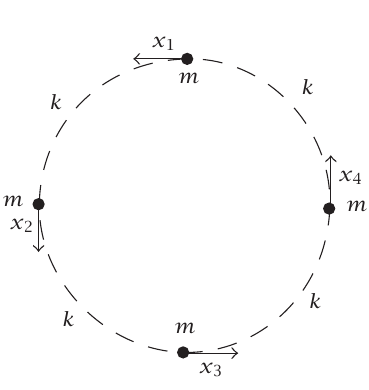
Figure 2.1 . Four particles on a